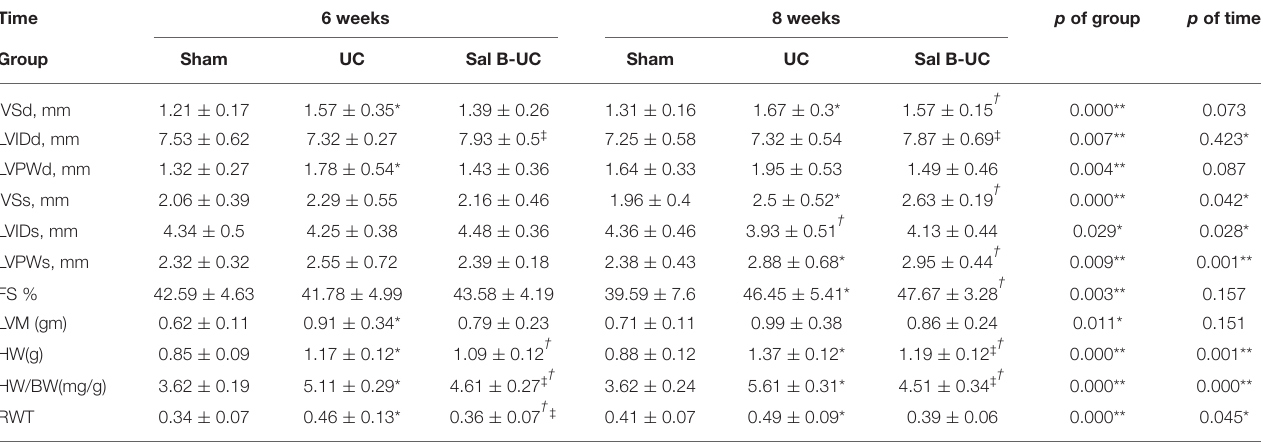
TABLE 1 | Cardiac morphology of the investigated groups at 6 and 8 weeks. Time 6 weeks 8 weeks p of group p of time Group